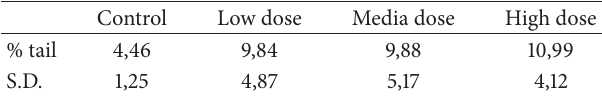
Table 4: Tail comet length as averages ± standard deviation. Control Low dose Media dose High